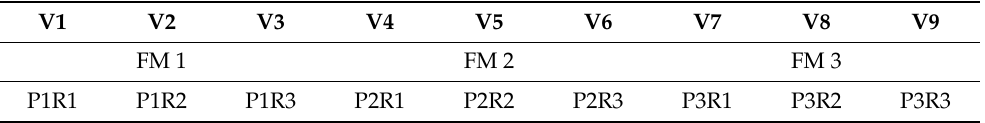
Table 3. Vector organization of orders by manufacturers.